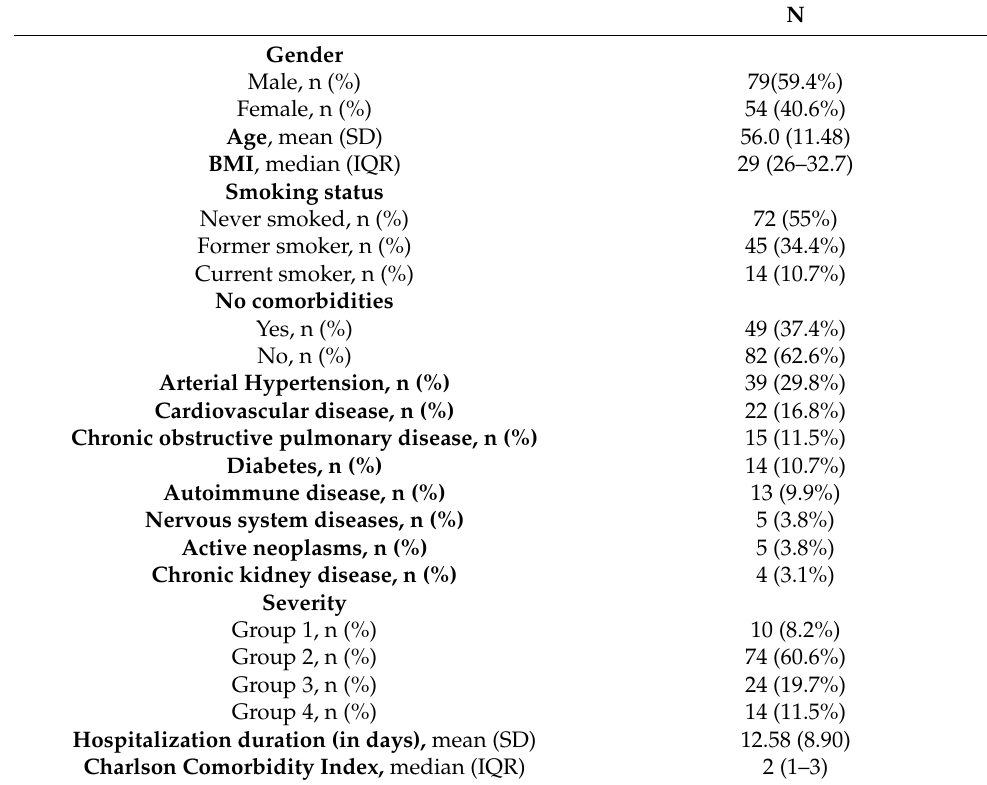
Table 1. Clinical characteristics of the